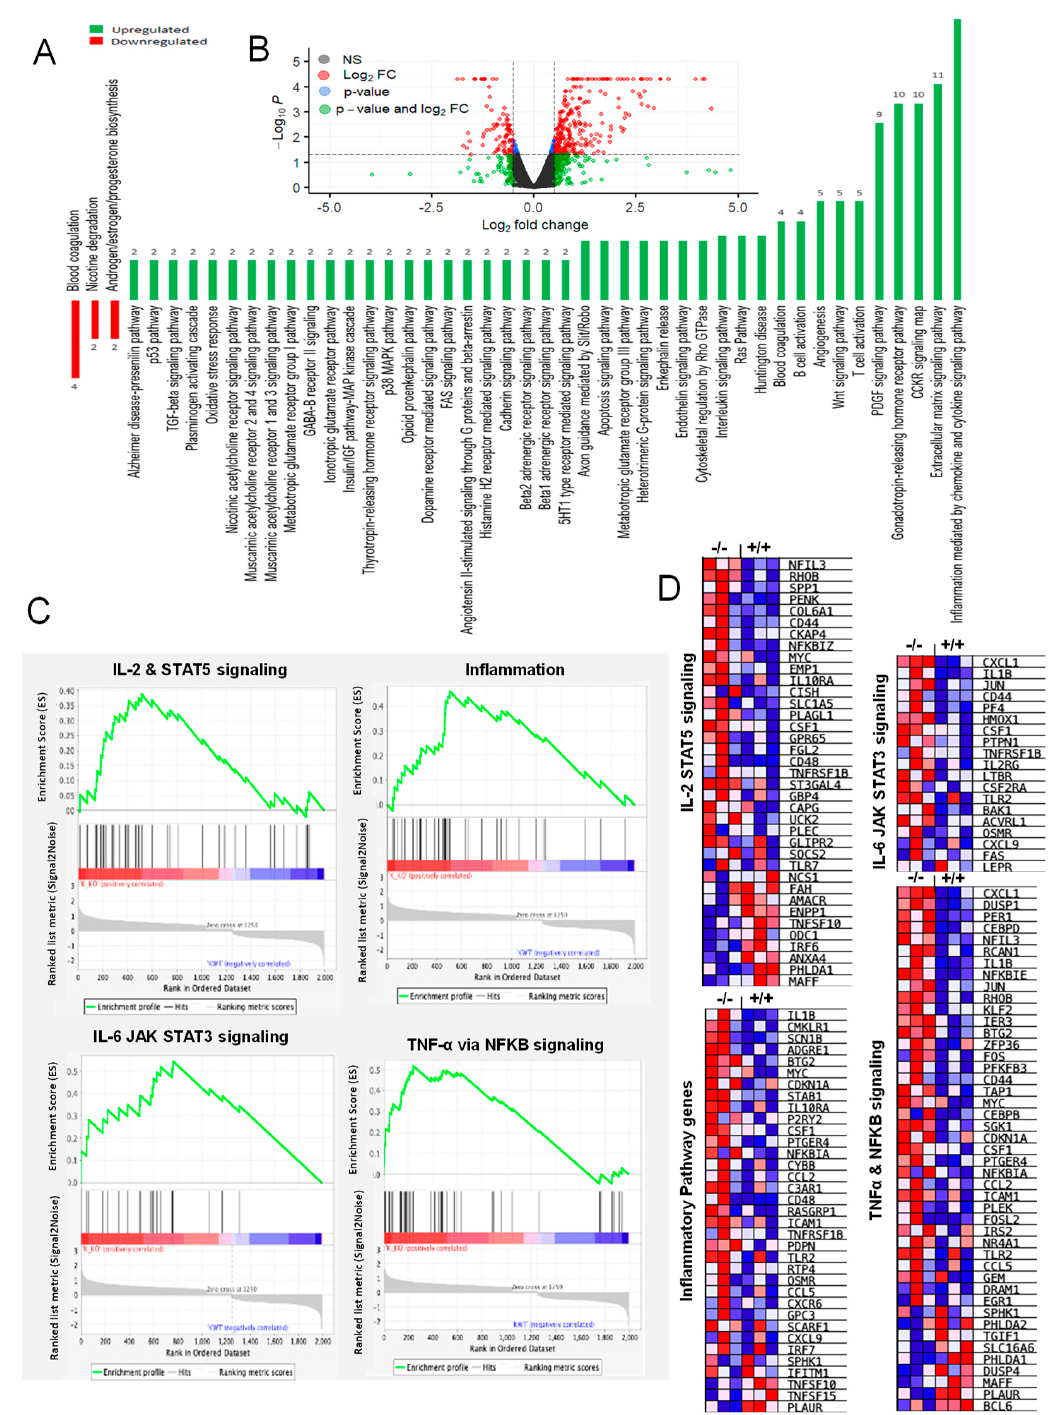
Figure 5. RNA-seq analysis reveals altered gene expression in Cldn17 − / − mouse kidneys. ( A ) Alteration in signaling pathways in the Cldn17 − / − mice against the WT group based on the Panther database. ( B ) Distribution of genes between WT and Cldn17 − / − mice on a volcano plot. ( C ) Gene enrichment plots (GO) and ( D ) heat maps (GSEA) for altered genes involved in the regulation of inflammation. Data represented for genes with fold-change >2; n = 3; GO, gene ontology; GSEA, gene set enrichment analysis; NS, not significant; FC, fold-change; IL, interleukin; TNF, tumor necrosis factor; +/+, WT; − / − , Cldn17 knockout; p < 0.05.